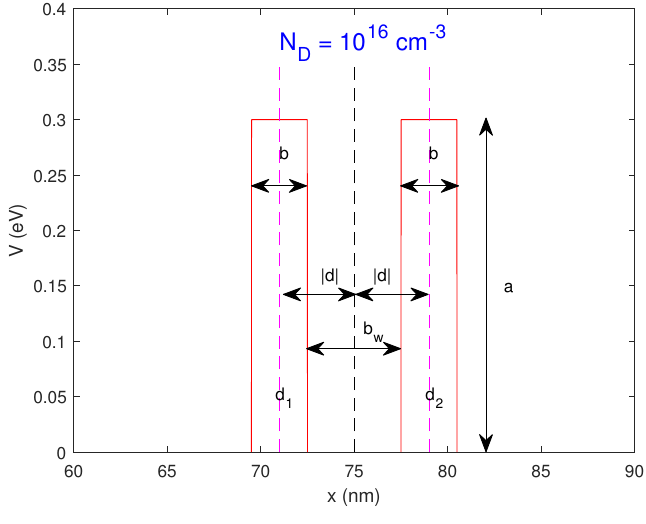
Figure 1. The quantum well